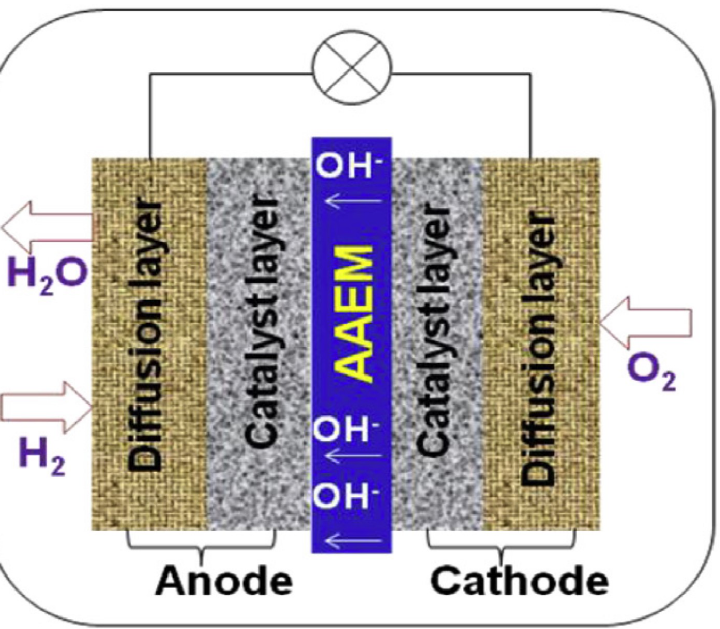
Figure 1. Schematic illustration of the working principle of AEMFCs. Reprinted with permission from [19]. Copyright 2015, for